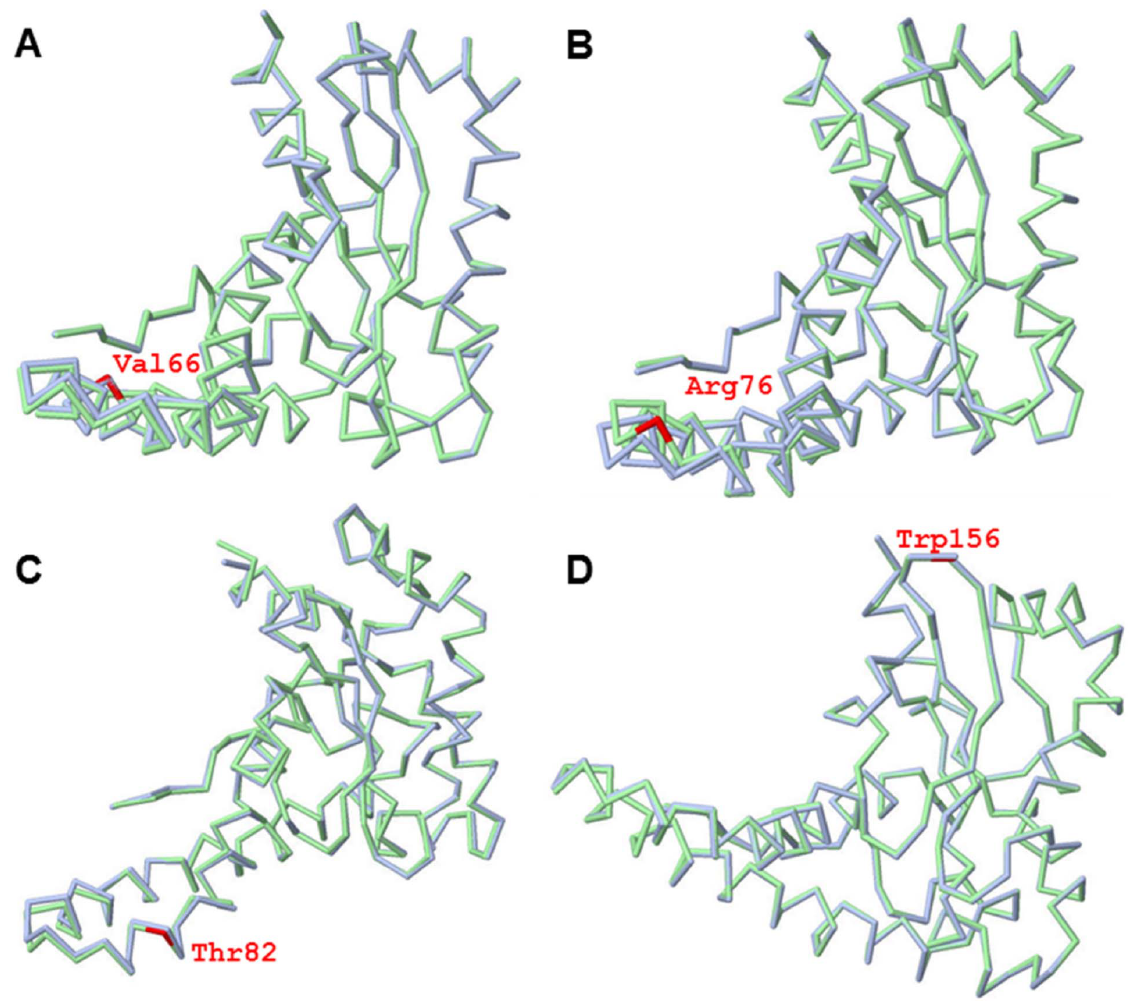
Figure 1. Superimposed native structures (green) and mutant structures (blue) of the SOD2 produced using comparative modelling. A) mutation E66V (E42V), RMSD: 0.21; B) mutation G76R (G52R), RMSD: 0.38; C) mutation I82T (I58T), RMSD: 0.45; D) mutation R156W (R132W), RMSD: 0.16.